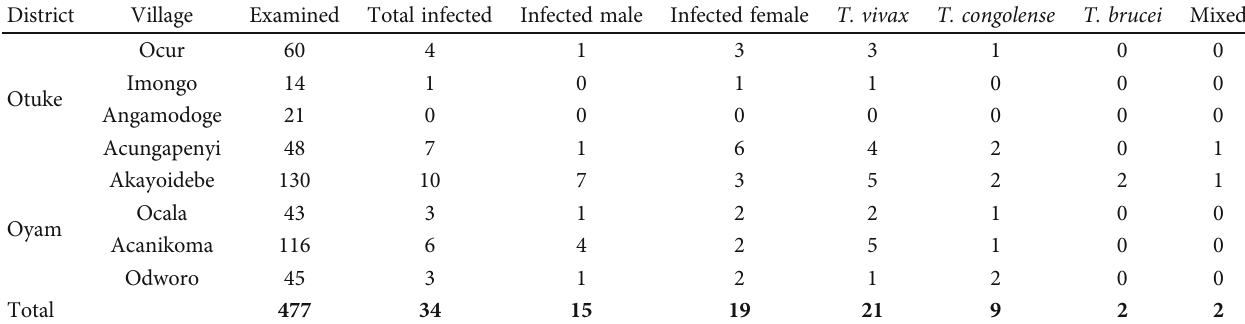
Table 2: Trypanosome infection rate and species in Oyam and Otuke